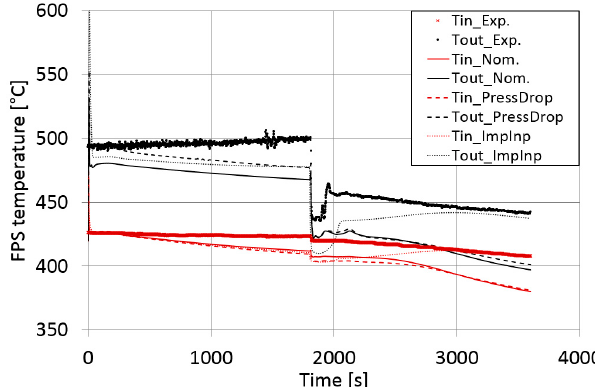
Figure 7. FPS inlet and outlet temperatures. Comparison between experimental data and numerical results obtained under different conditions.